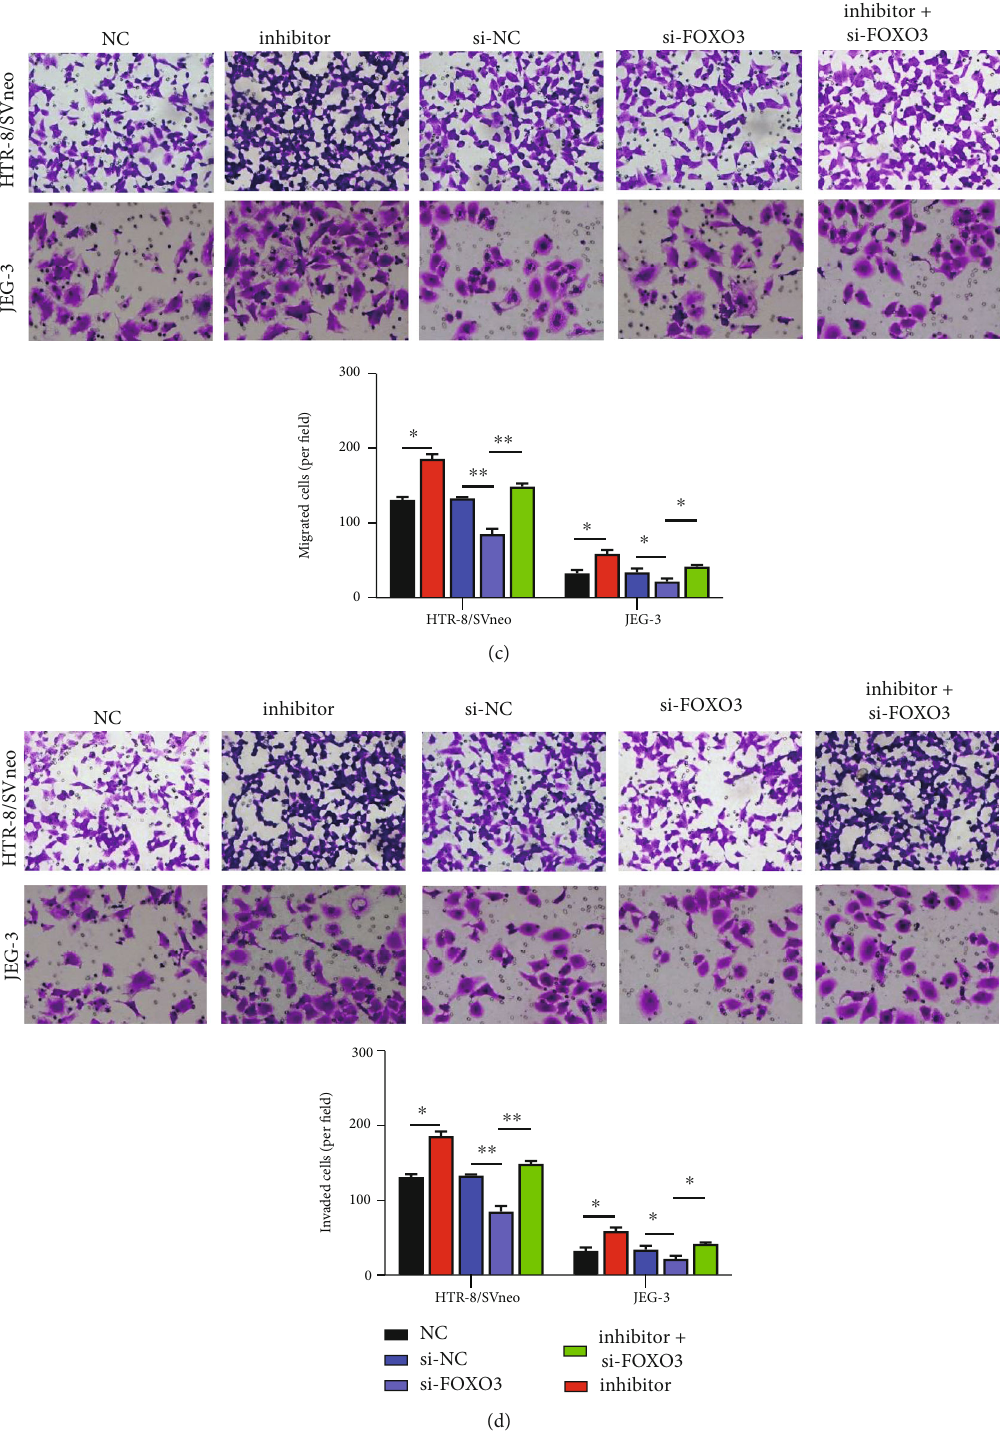
Figure 5: miR-155 knockdown increased cell viability, migration, and invasion in trophoblast cells by upregulating FOXO3. HTR8/SVneo and JEG-3 cells were transfected with NC, inhibitor, si-NC, si-FOXO3, and inhibitor + si-FOXO3, respectively. (a) Cell viability was evaluated by CCK-8 assay in the above-transfected cells. (b) Detection of cell apoptosis by TUNEL assay. Transwell assay was used to analyze cell migration (c) and invasion (d) in the above-transfected cells. ∗ P < 0 : 05 , and ∗∗ P < 0 : 01